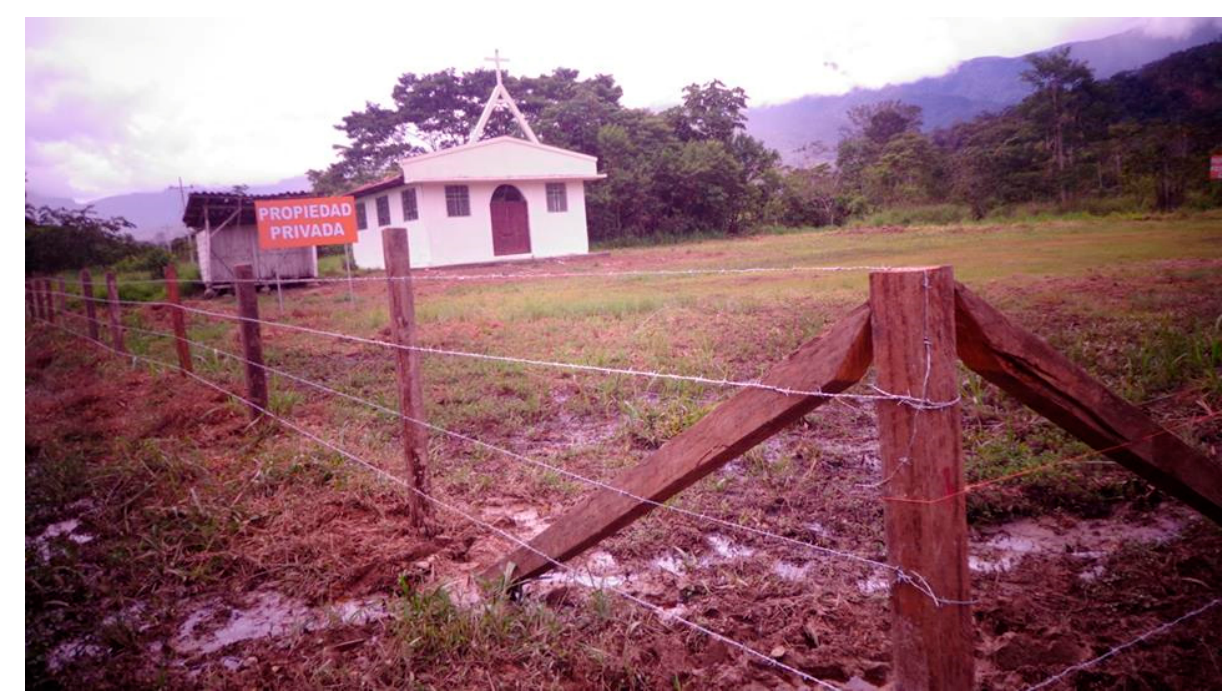
Figure 2. The chapel of San Marcos, with a sign reading ‘private property’. Source: INREDH.